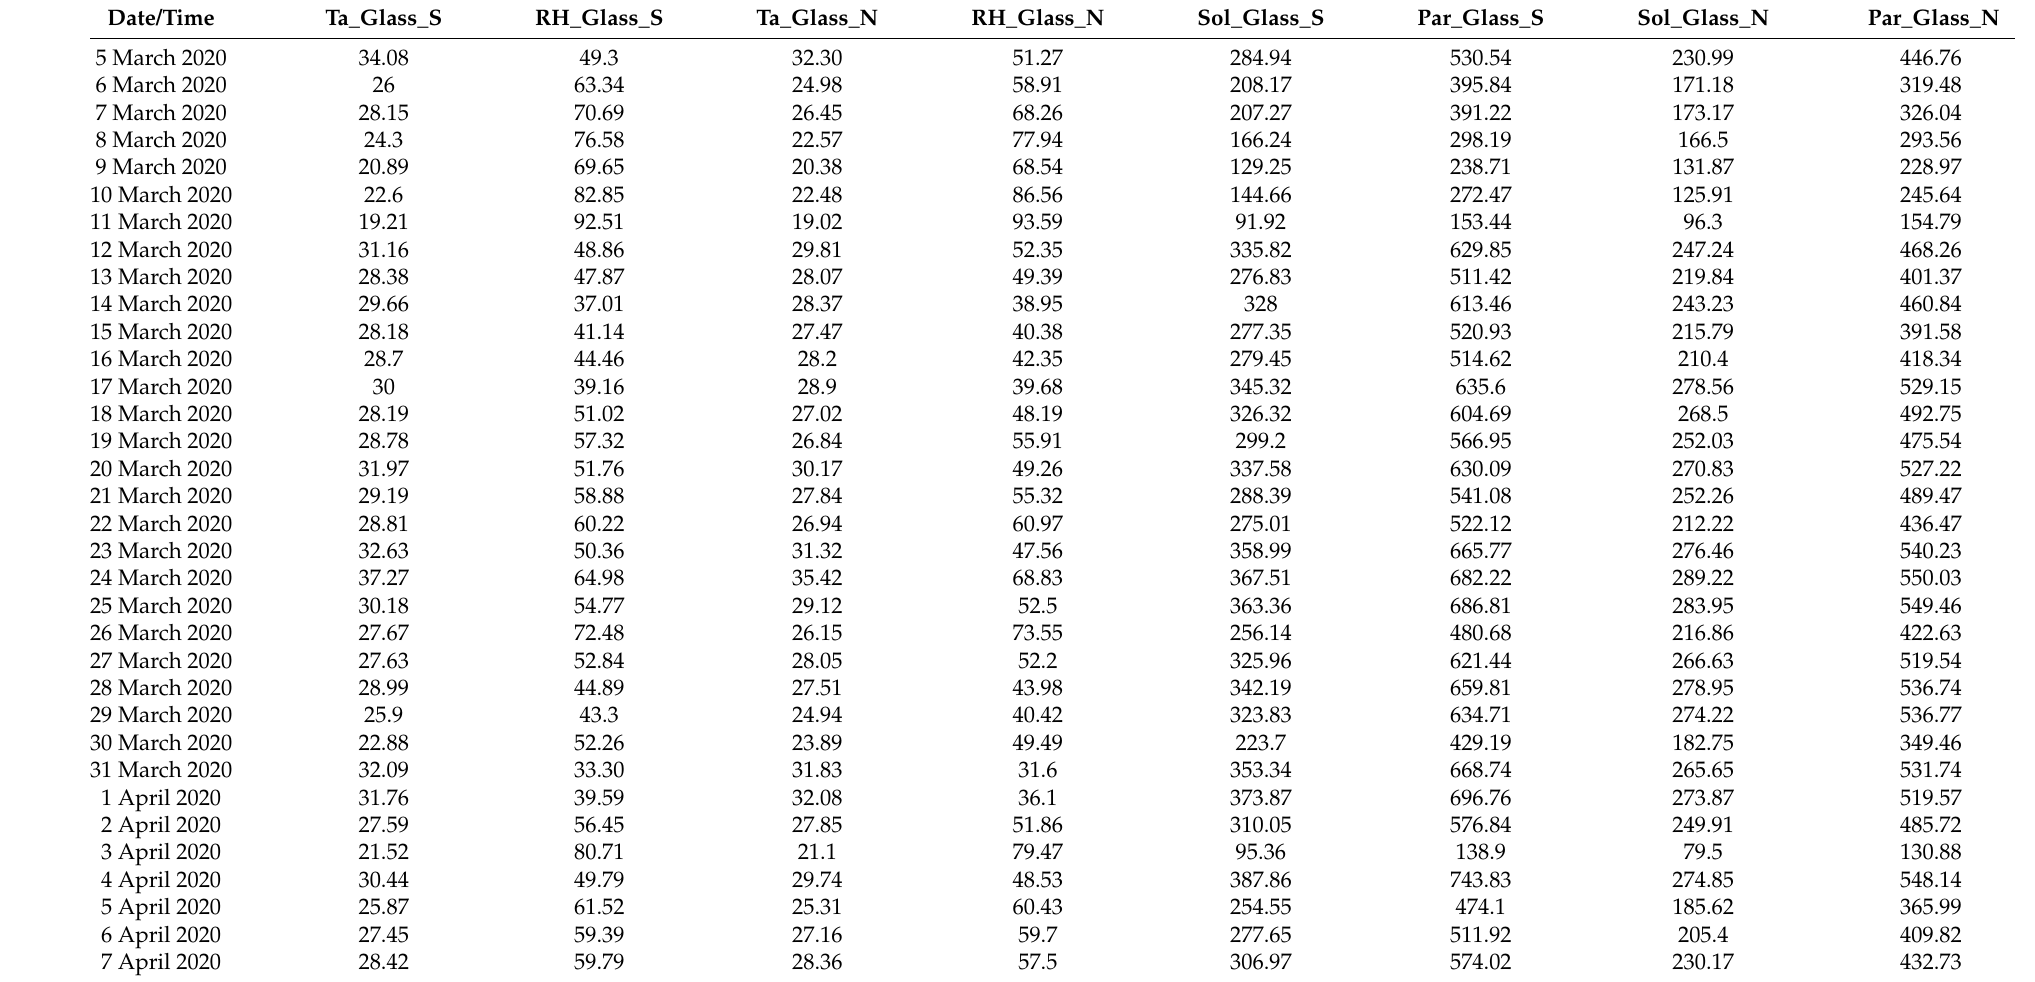
Table 4. Mean day-time variations of climatic parameters over the measurement